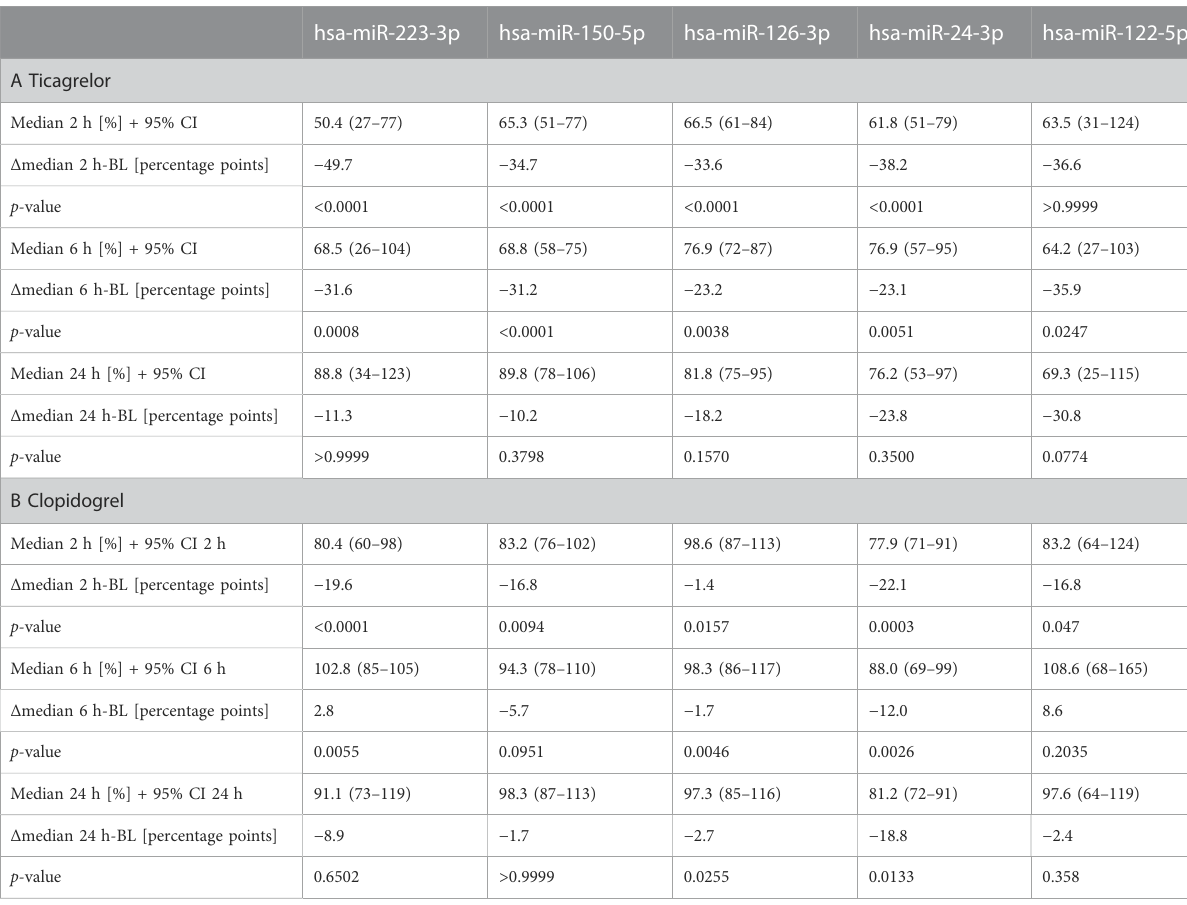
TABLE 1 Effects of ticagrelor (A) and clopidogrel (B) treatment on platelet-enriched miRNA levels in plasma. Median values after 2 h, 6 h, and 24 h are in comparison to the median of the baseline. Donors with missing values were removed from statistical analysis (Friedman test with Dunn ’ s multiple comparisons test).